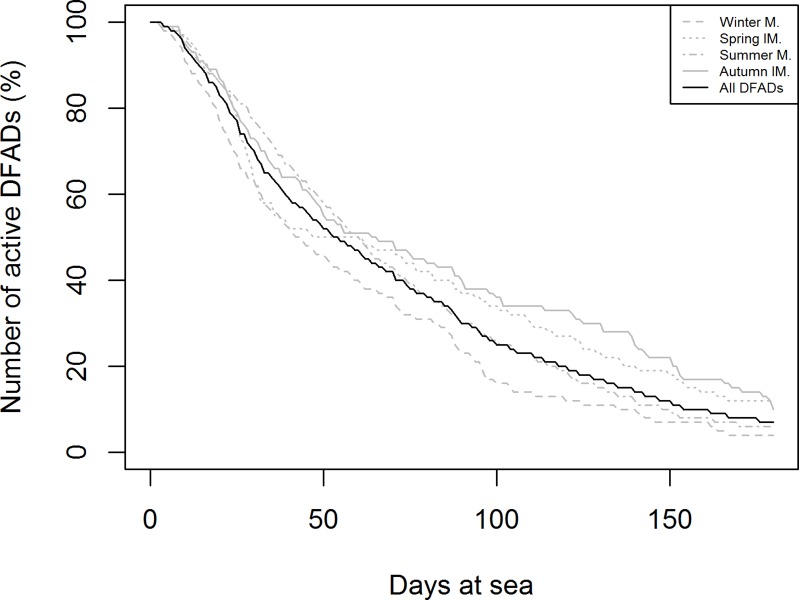
Percentage of DFADs available over 180 days for all DFADs (black line) and for DFADs deployed in different seasons (grey lines).